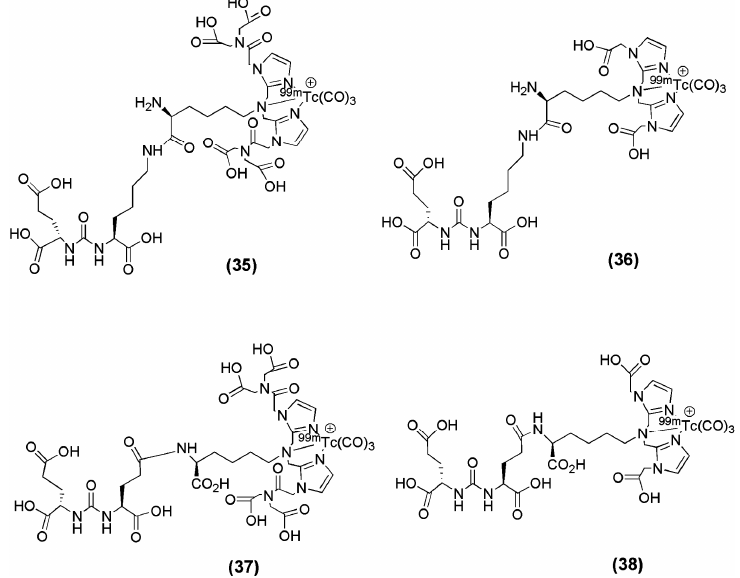
Figure 10. Chemical structures of 99m Tc-MIP-1428 ( 35 ), 99m Tc-MIP-1405 ( 36 ), 99m Tc-MIP-1404 ( 37 ) and 99m Tc-MIP-1427 ( 38 ) [103].